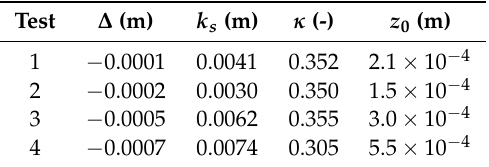
Table 6. Parameters describing the log-law for Scenario 4, where κ is not considered universal and B =